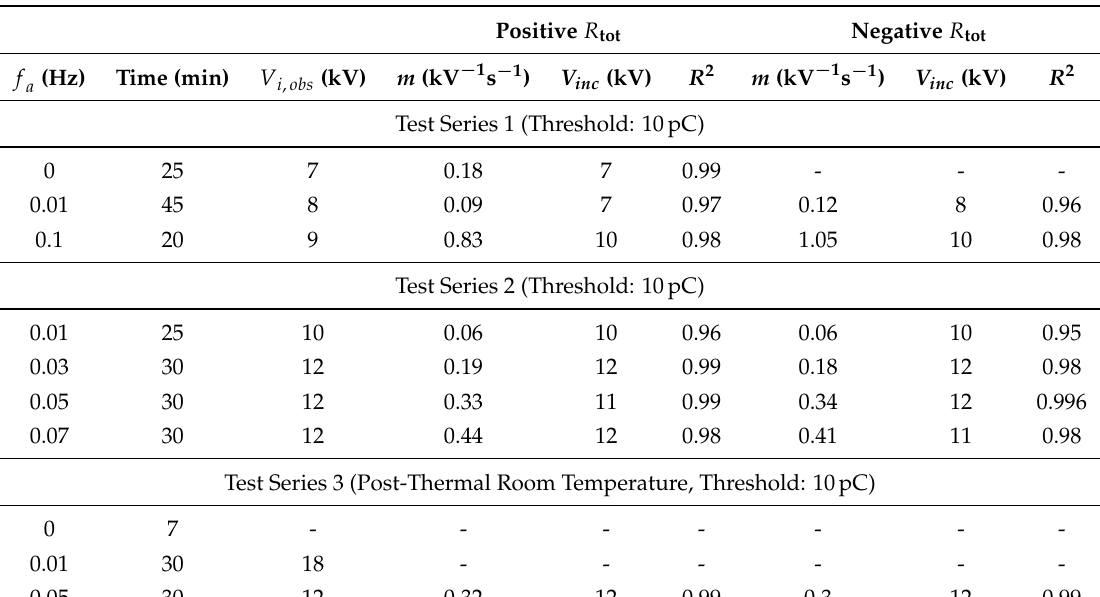
Table 2. Linear regression results for empirically measured variation in a total repetition rate with applied voltage for different frequencies at room temperature. Positive R tot Negative R